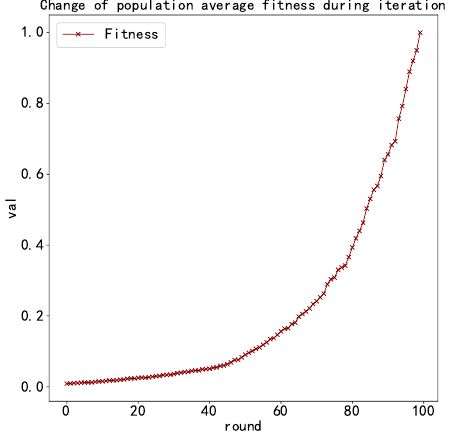
Figure 7. Change in population’s average fitness.